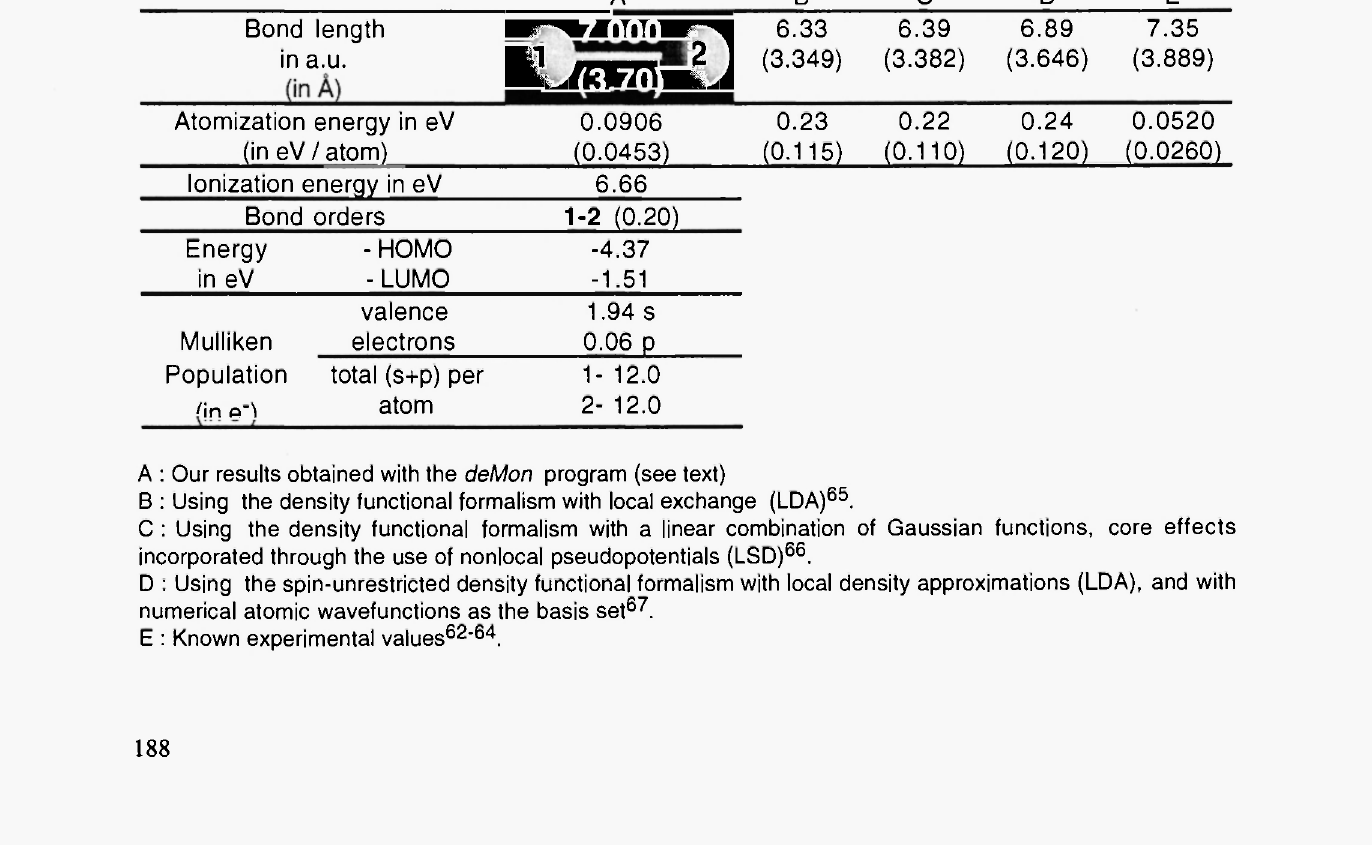
Figure 1 : Atomization, ionization and HOMO / LUMO orbital energies, bond length, total and valence electrons Mulliken population for Mg ?